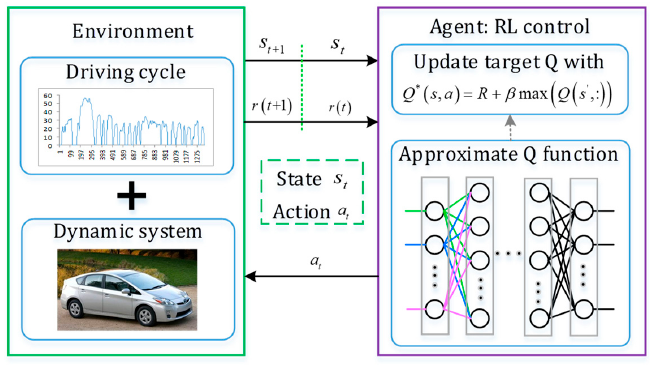
Figure 10. Depiction of the schematic diagram of the RL-based strategy.